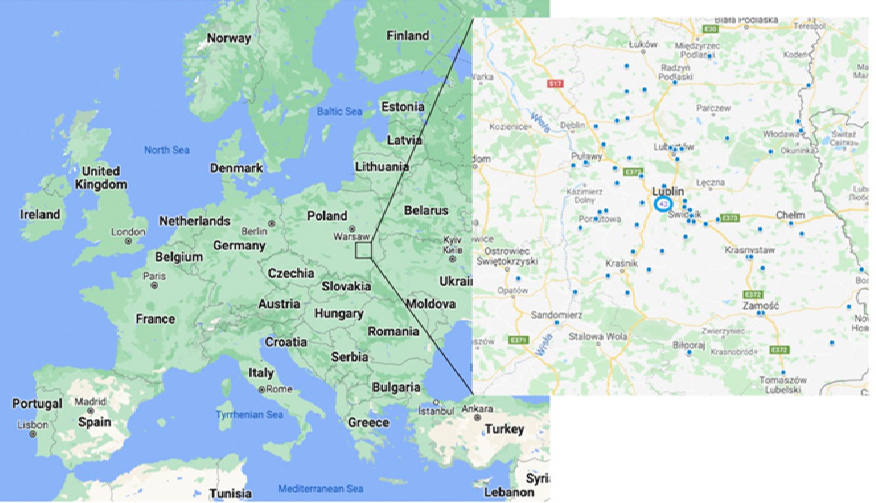
Figure 1. Distribution of radon exposure measurement sites in the Lublin region, Poland. Poland Google Maps. 2022. Lublin. 1:1,000,000. Google Maps [online]. Available online: https://www. google.com/maps (accessed on 1 February